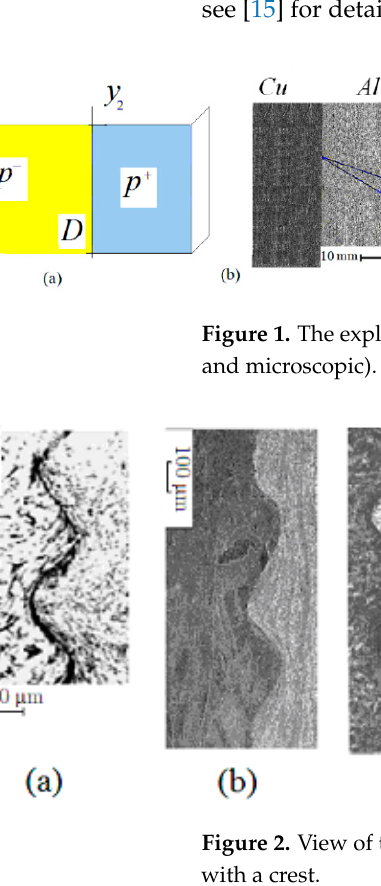
Figure 2. View of the weld at a microlevel: ( a ) symmetric wave; ( b , d ) asymmetric wave; ( c , e , f ) wave with a crest.